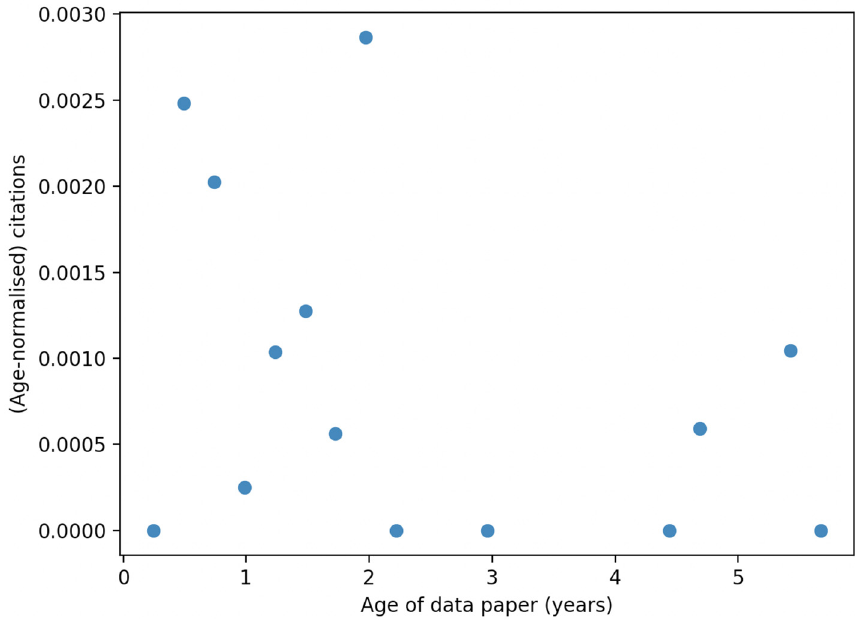
Figure 8. JOHD/RDJ data papers: average citation counts over time. The number of years of age of the papers indicated on the x -axis has been divided into 3-month intervals.